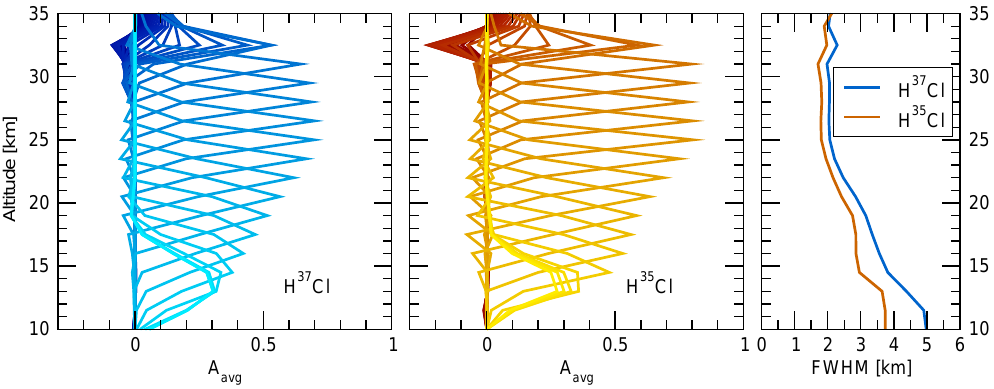
Fig. 4. Averaging kernels for H 37 Cl (left panel) and H 35 Cl (centre) with the FWHM of the kernels in respectively blue and red (right panel).